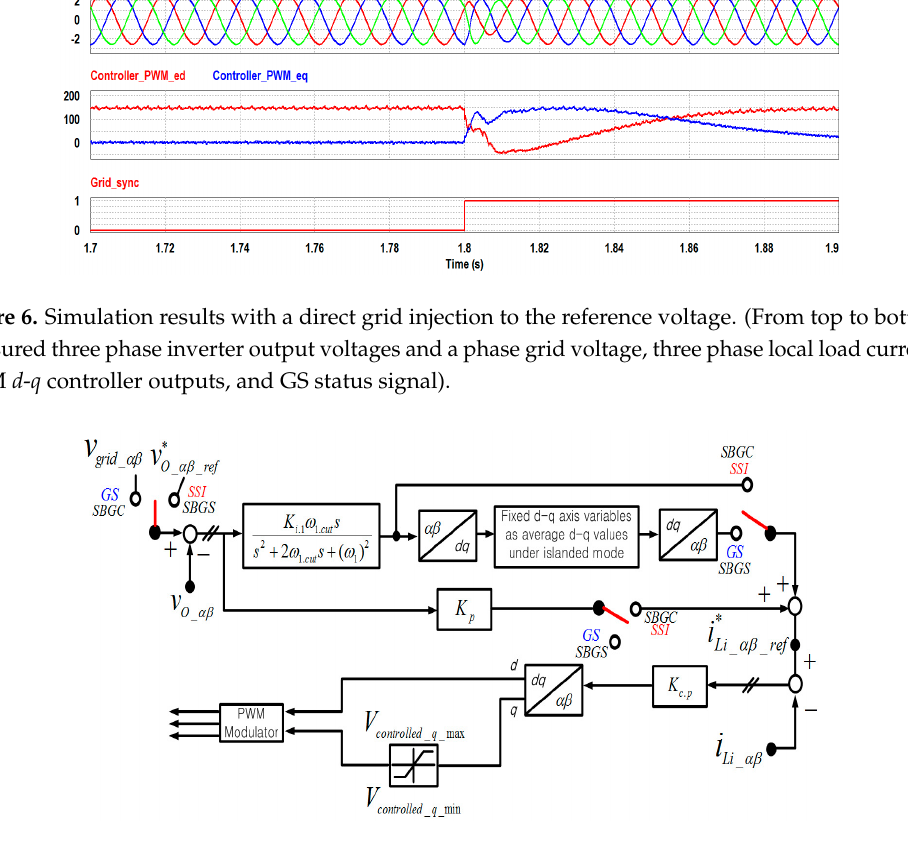
Figure 7. Block diagram of multi loop output voltage control-based grid synchronization method in [11] (Islanded mode changes from SSI (Steady State of Islanded mode) ⟶ SBGS (Standby mode for Grid Synchronization) ⟶ GS (Grid Synchronization) ⟶ SBGC (Standby mode for Grid Connection)).